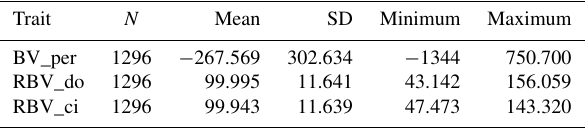
Table 5. Descriptive statistics for RBVs of reproduction traits and BV of lactation persistency.